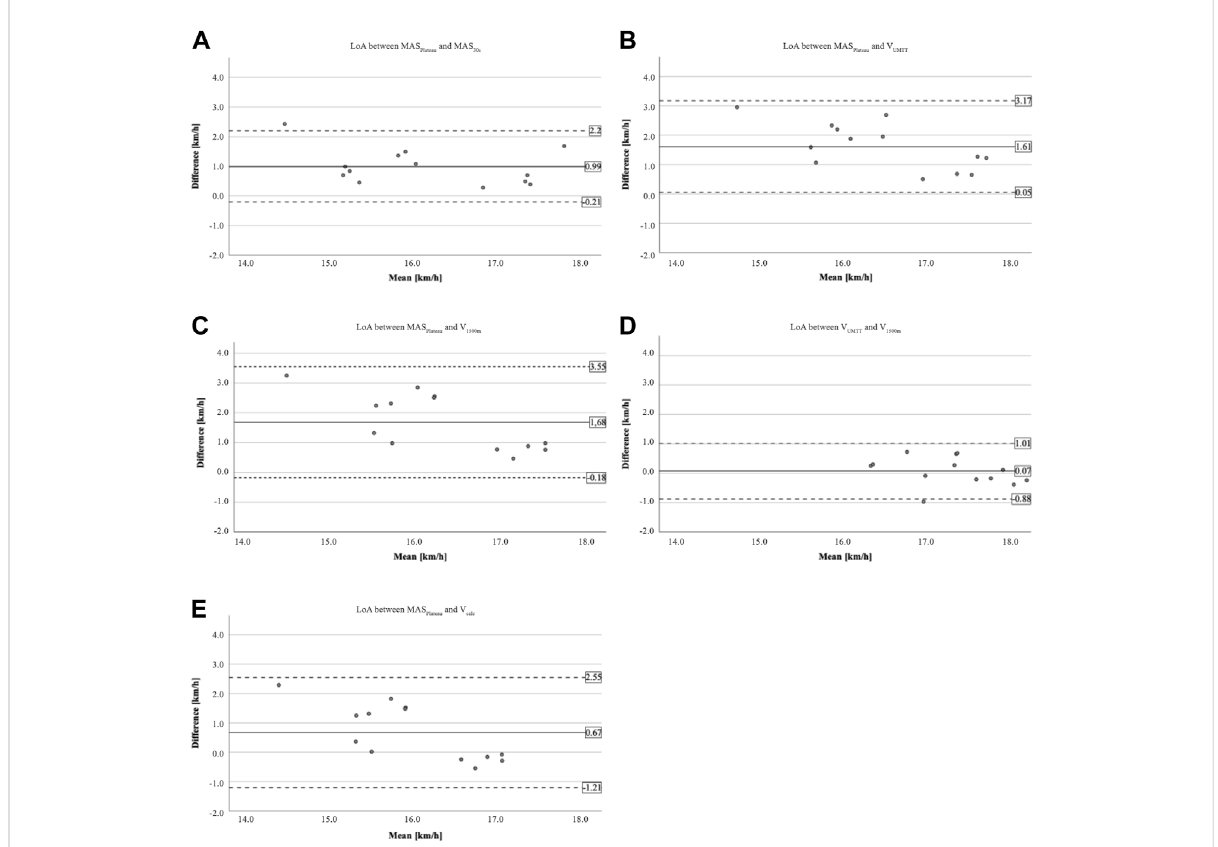
FIGURE 2 Bland-Altman plots for limits-of-agreement analysis (LoA analysis) between (A) MAS Plateau and MAS 30s ; (B) MAS Plateau and V UMTT ; (C) MAS Plateau andV 1500m ; (D) V UMTT and V 1500m ; and (E) MAS Plateau and V calc . The solid lines represent the mean difference, the dashed lines represent the limits of agreement (±1.96